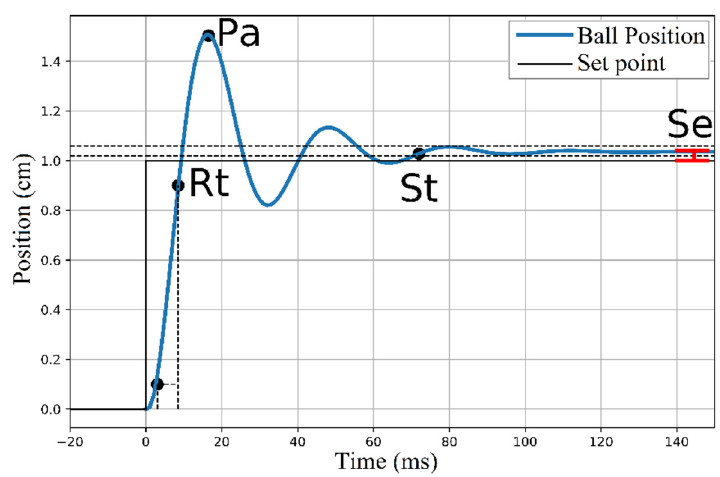
Figure 6. Performance coefficients.